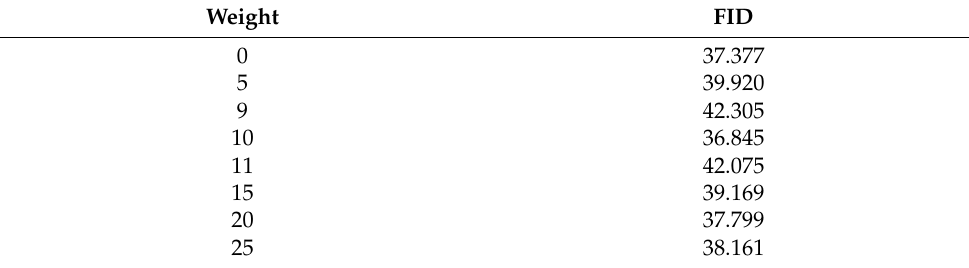
Table 3. FID value of content reconstruction loss under different weights.